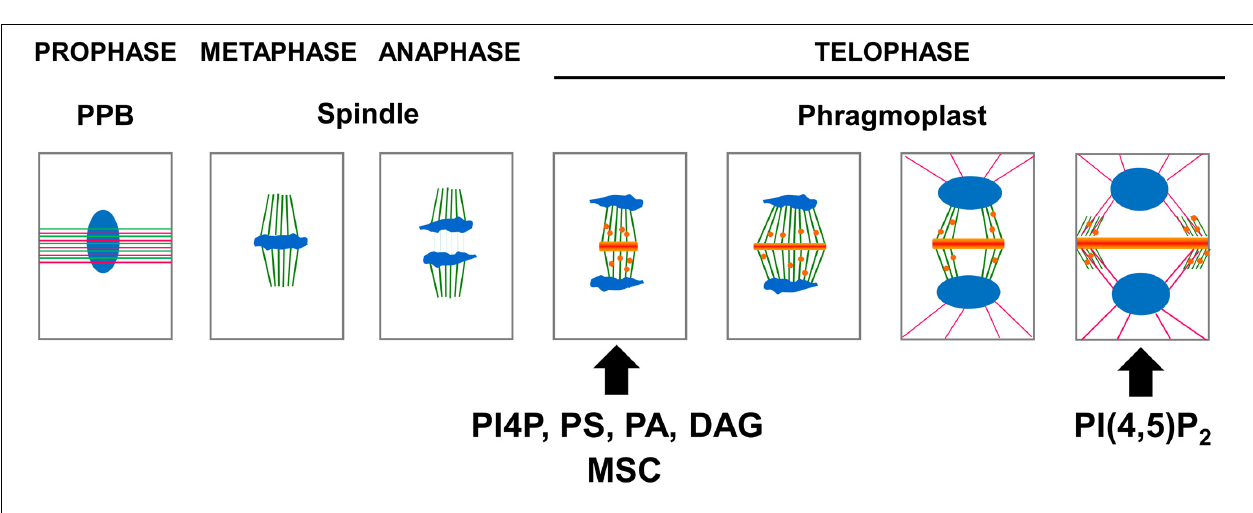
FIGURE 3 | Schematic representation of the apparition of the anionic lipid at the cell plate. In preprophase, cortical microtubules (green) and actin filaments (pink) reorganize into a cortical ring positioned at the center of the cell named the preprophase band (PPB). At the end of prophase an acentriolar spindle is formed. After the separation of the chromosomes (blue), the transport along the phragmoplast of vesicle (orange) derived from the Golgi apparatus and, or trans -Golgi network (TGN) accumulate in the center of the cell, forming the cell plate. At this stage, PI4P, PS, PA, and DAG could be observed using their respective biosensors. The gradual expansion of the phragmoplast allows growth of the cell plate toward the periphery of the mother cell. When the phragmoplast reaches its maximum expansion, the neo-formed cell plate connects to the primary wall of the mother cell. At this stage, PI(4,5)P 2 could be observed using its corresponding biosensor. The timing of apparition at the cell plate of each anionic lipids as well as membrane surface charge biosensor (MSC) are represented